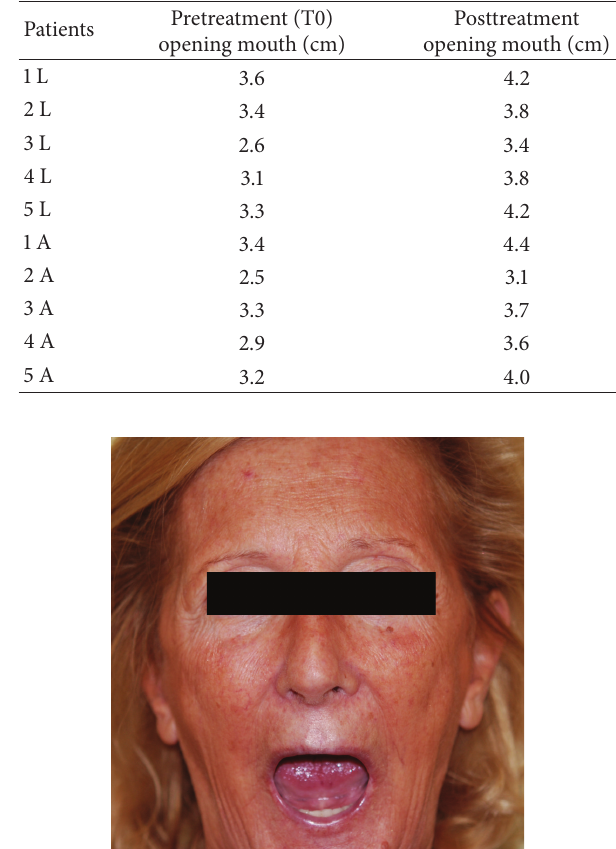
Table 3: Maximal Mouth Opening (MMO) by measuring the distance between the tips of upper and lower right incisive teeth.